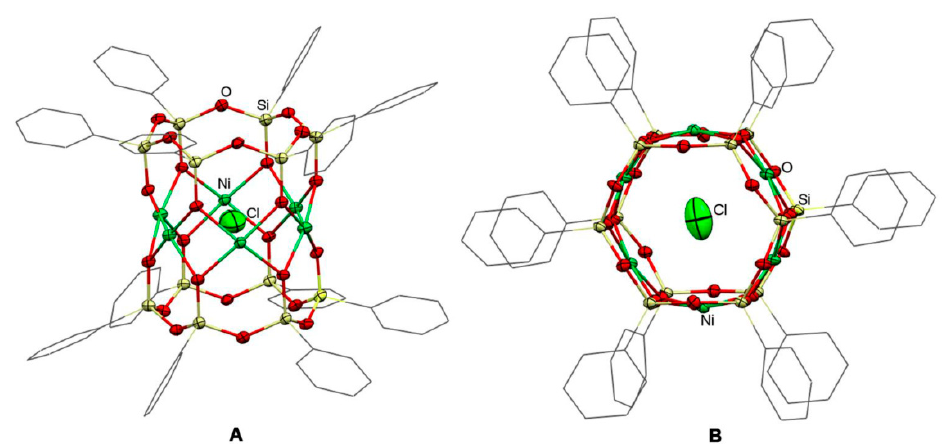
Figure 30. Molecular structure of compound 32 (( A )—side view, ( B )—top view). Solvating ligands and counter ion Na + are omitted for clarity. Adapted from Ref. [164], Copyright (2016) from Molecules MDPI (Open Access).